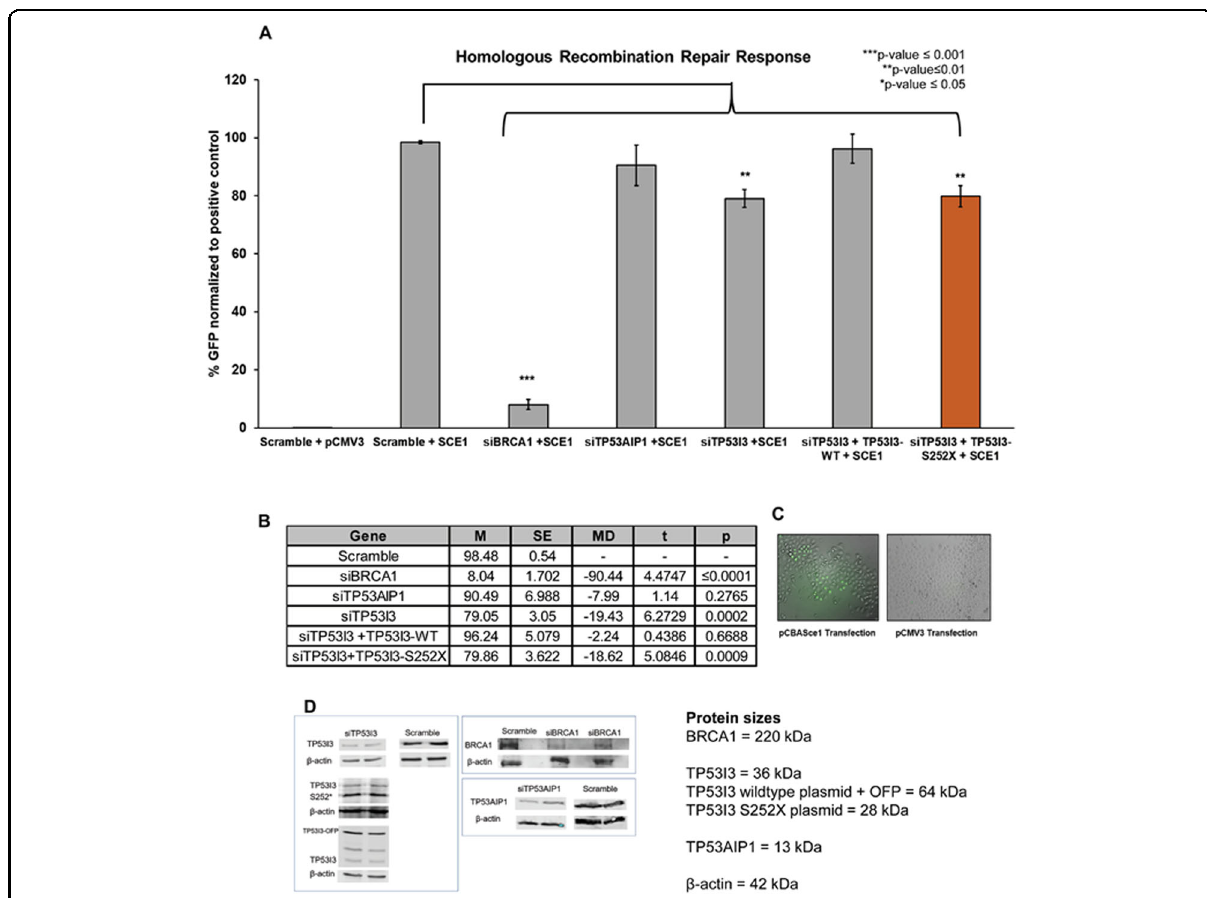
Fig. 2 Effect of TP53I3-S252X on homologous recombination repair. HeLa-DR-GFP cells carry two inactive GFP alleles, the fi rst allele contains the SCE1 endonuclease and the second allele is truncated. The introduction of pcBASce-1 to the cells causes a double-stranded break in the fi rst GFP allele and the second GFP allele acts as a template for the HRR of the lesion. GFP expression is a quanti fi able measurement of HRR using fl ow cytometry. A Effect of siRNA knockdown of BRCA1, TP53AIP1, TP53I3, or TP53I3 with wildtype (TP53I3-WT) or mutant plasmid (TP53I3-S252X). B Calculated two-way t test for each condition compared with scramble-positive control. With an n = 7, p values ≤ 0.05 were considered statistically signi fi cant. C Fluorescent imaging of HeLa-DR-GFP cells repairing DSB with HRR compared to empty vector pCMV3. D Representative western blots for knockdown of TP53I3, TP53I3 rescue with wildtype, TP53I3 rescue with mutant (TP53I3-S252X), BRCA1, and TP53AIP1. The signi fi cance test was based on comparing the positive control, Scramble siRNA with SCE1 plasmid, to knockdown and/or rescue